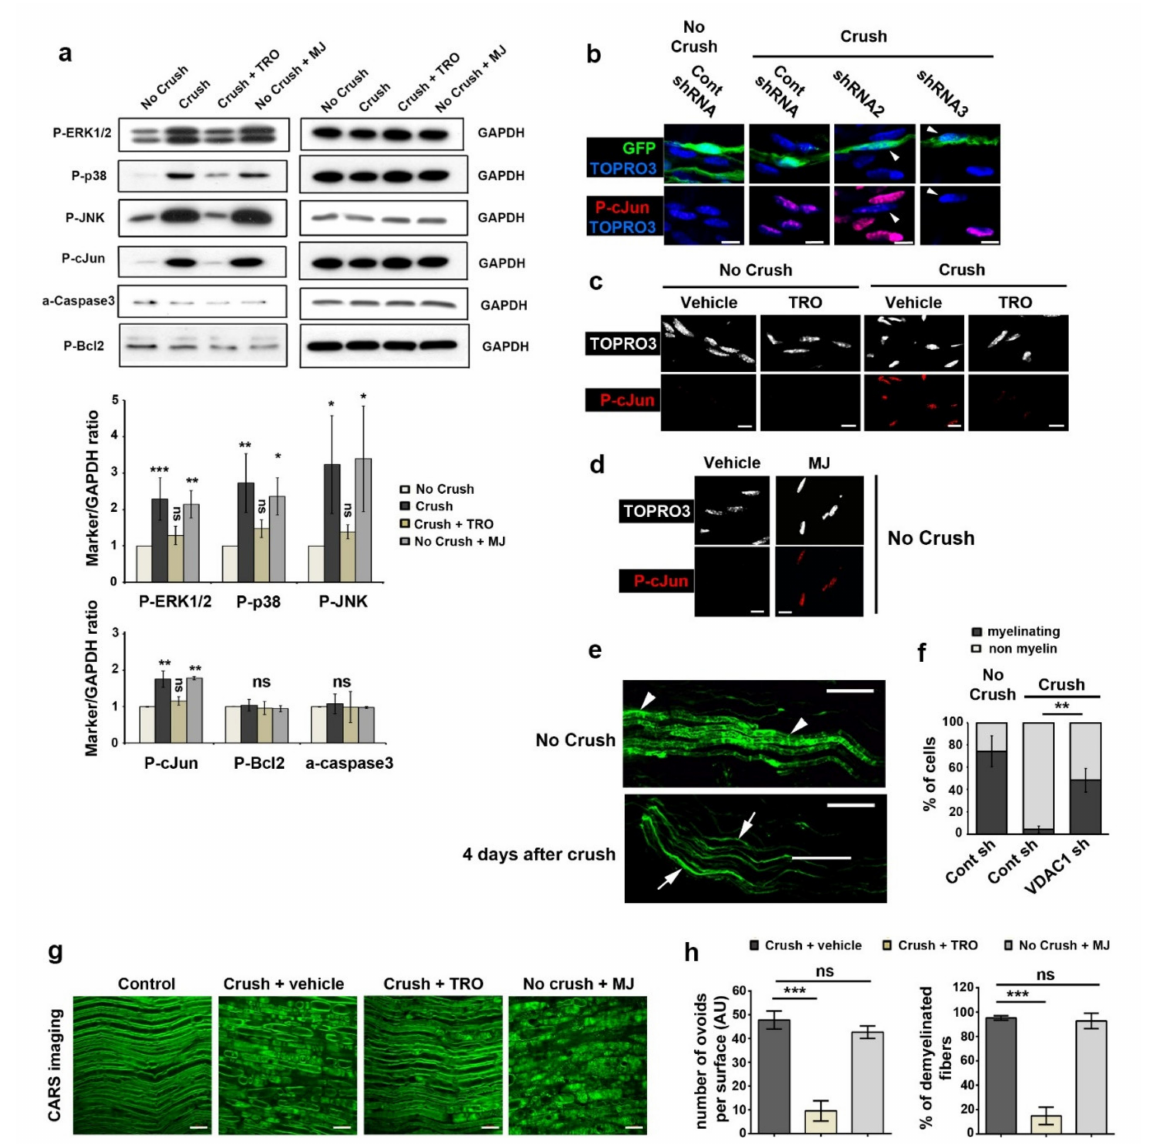
Figure 6. Demyelination is decreased after treatment with TRO19622 and spontaneously induced after treatment with MJ. ( a ) Upper panels: Western blot analysis for phospho-ERK1/2 (P-ERK1/2), phospho-p38 (P-p38), phospho-JNK (P-JNK), phospho-cJun (P-cJun), activated cleaved-caspase3 (a-caspase3) and phospho-Bcl2 (P-Bcl2) in the sciatic nerve of mice without injury (No crush), 4 h after injury (Crush), 4 h after injury with TRO19622 treatment 30 min before injury (Crush + TRO), or without injury but 4 h after methyl jasmonate treatment (No crush + MJ). GAPDH was used as loading control. Blots were stripped and re-hybridized with different antibodies against proteins of interest, so GAPDH is a loading control for different immunoblots. n = 3 independent experiments. Lower panels: WB results analyzed by densitometry and normalized on GAPDH respective values on the same blot. As similar changes were observed at 4 and 12 h after injury (see Figure S3 for 12 h representative images), data from both experiments were pooled except for P-cJun, for which changes were consistent but much higher at 12 h. So, only 4 h data are presented. All data are presented as fold over No crush condition. Error bars show SD. Statistical tests are one-way ANOVA followed by a Dunnett’s multiple comparison post hoc tests for each marker. n = 2 (P-cJun) to 4 mice. ns = non-significant. ( b ) Immunohistochemistry for phospho-cJun (P-cJun, red) and nuclear TOPRO3 (blue) on teased fibers of mouse nerve transduced with virus expressing control shRNA or shRNA 2 or 3 targeting VDAC1 in addition to GFP (green). Without injury (No crush) non infected cells or